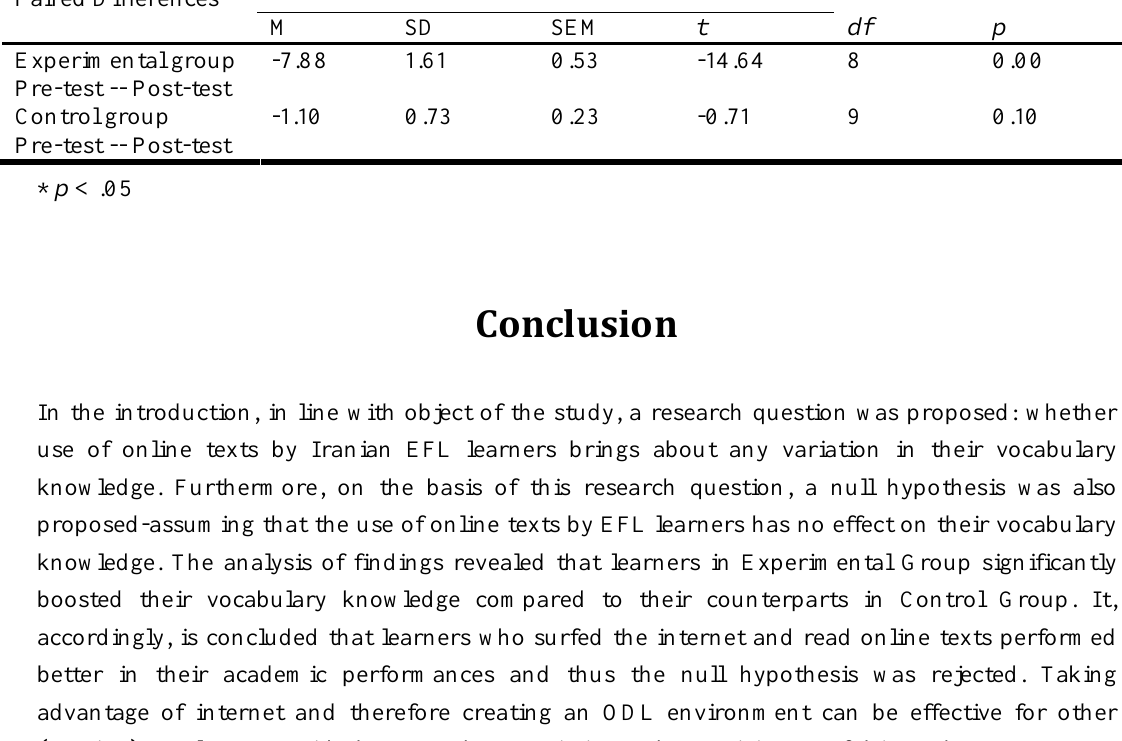
Table 3 Paired T-Test for Pre- and Post-Tests of the Experimental and Control Groups Paired Differences M SD SEM t df p Experimental group -7.88 1.61 0.53 -14.64 8 0.00 Pre-test -- Post-test Control group -1.10 0.73 0.23 -0.71 9 Pre-test -- Post-test